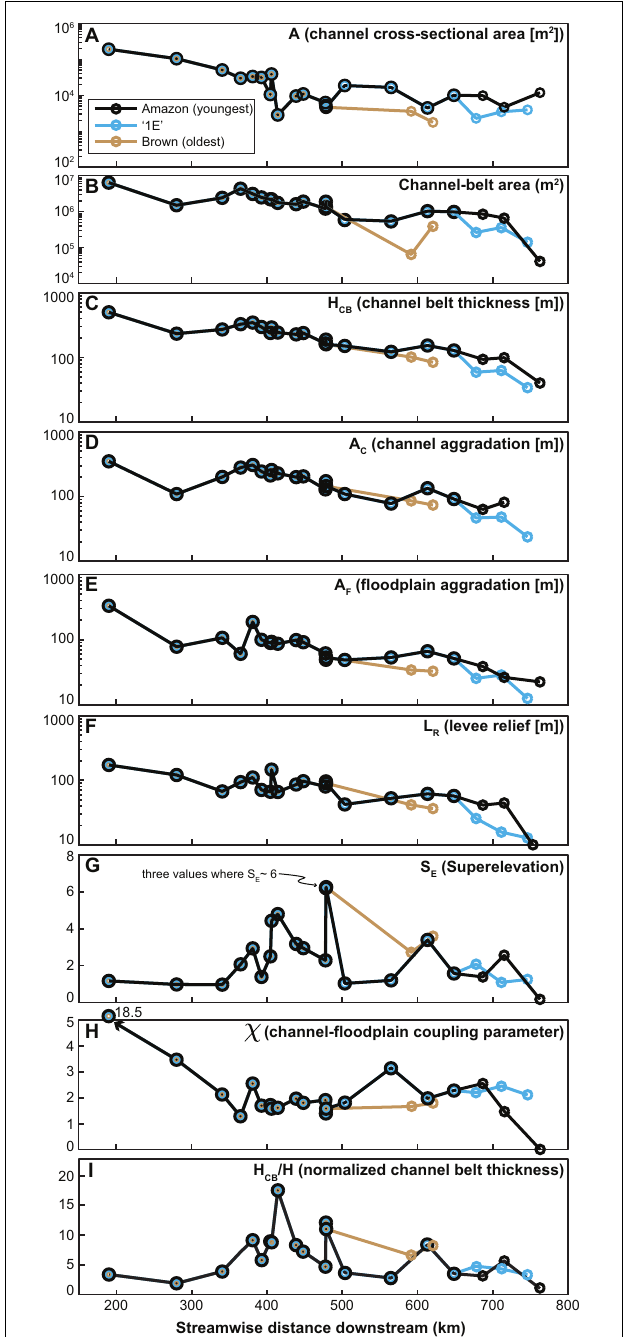
FIGURE 10 | Downstream channel-belt metrics for the Amazon submarine channel. Most channel and channel-belt metrics show a distinct downstream decrease (A–F) , consistent with models of channel-belt evolution and aggradation. However, superelevation (G) shows low values upstream (near the canyon-channel transition) and a peak near the Brown-channel avulsion node, indicating a potential linkage between superelevation and avulsion location. In (H) , note the consistent values of χ , indicating strong channel-floodplain coupling throughout the downstream channel evolution. Normalized channel-belt thickness (I) also shows this relationship, supporting the formulation of Eq.